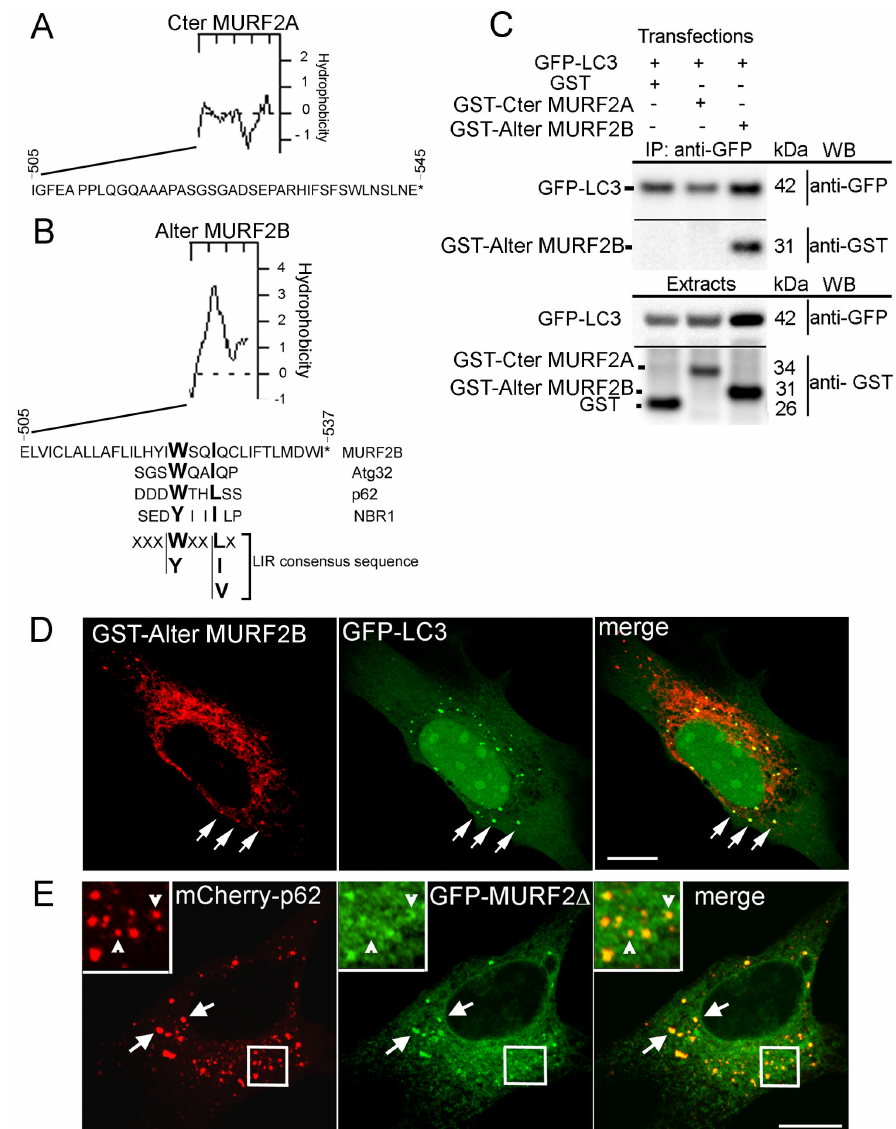
Figure 4. A LIR sequence mediates interaction of MURF2B with LC3. (A,B) Predicted hydrophobicity and aa sequences of the human C-terminus of MURF2A (A, Cter MURF2A) and of the Alternative C-terminus of MURF2B (B, Alter MURF2B). LIR sequences of various proteins and consensus sequence are aligned with the MURF2B C-terminus. (C) The MURF2B LIR domain interacts with LC3. C2C12 myoblasts were transfected with various pairs of vectors encoding GFP-LC3, GST, GST- MURF2A C-terminus domain (GST- Cter MURF2A) or the GST- MURF2B Alternative C-terminus domain (GST-Alter MURF2B). One day after transfection, cells were differentiated for 24h day in 1% HS medium then cultured for 2h 30 min in HBSS medium containing 0.1% BSA, 50 µM MG132 and 200 nM Baf. Immunoprecipitation were performed with GFP-Trap magnetic beads and 400 µg of extracts in RIPA buffer and subjected to SDS-PAGE (IP: anti-GFP). Exogenous proteins were detected with anti-GFP and anti-GST antibodies by Western blot (WB). For each transfection, 20 µg protein extract was used to reveal the expression of exogenous proteins (Extracts). (D) The Alternative C-terminus domain of MURF2B interacts with vesicles decorated with LC3 and the C-terminus domains of the MURF2 isoforms are not needed for MURF2/p62 interactions. Immunofluorescence experiments were performed with C2C12 cells transfected with GST-Alter MURF2B and GFP-LC3 vectors and stained with anti-GST antibody (red). GFP-LC3 was observed directly (green) with confocal microscope. Co-localizations are highlighted by arrows. (E) C2C12 cells were also transfected with the GFP-MURF2Δ and mCherry-p62 vectors and observed by confocal microscopy. Arrows show vesicles displaying both exogenous proteins. Enlarged views reveal curved structures, labelled with GFP-MURF2Δ, in close contact with p62 vesicles (empty arrowheads). Scale Bars: 10 µm. doi: 10.1371/journal.pone.0076140.g004 PLOS ONE |